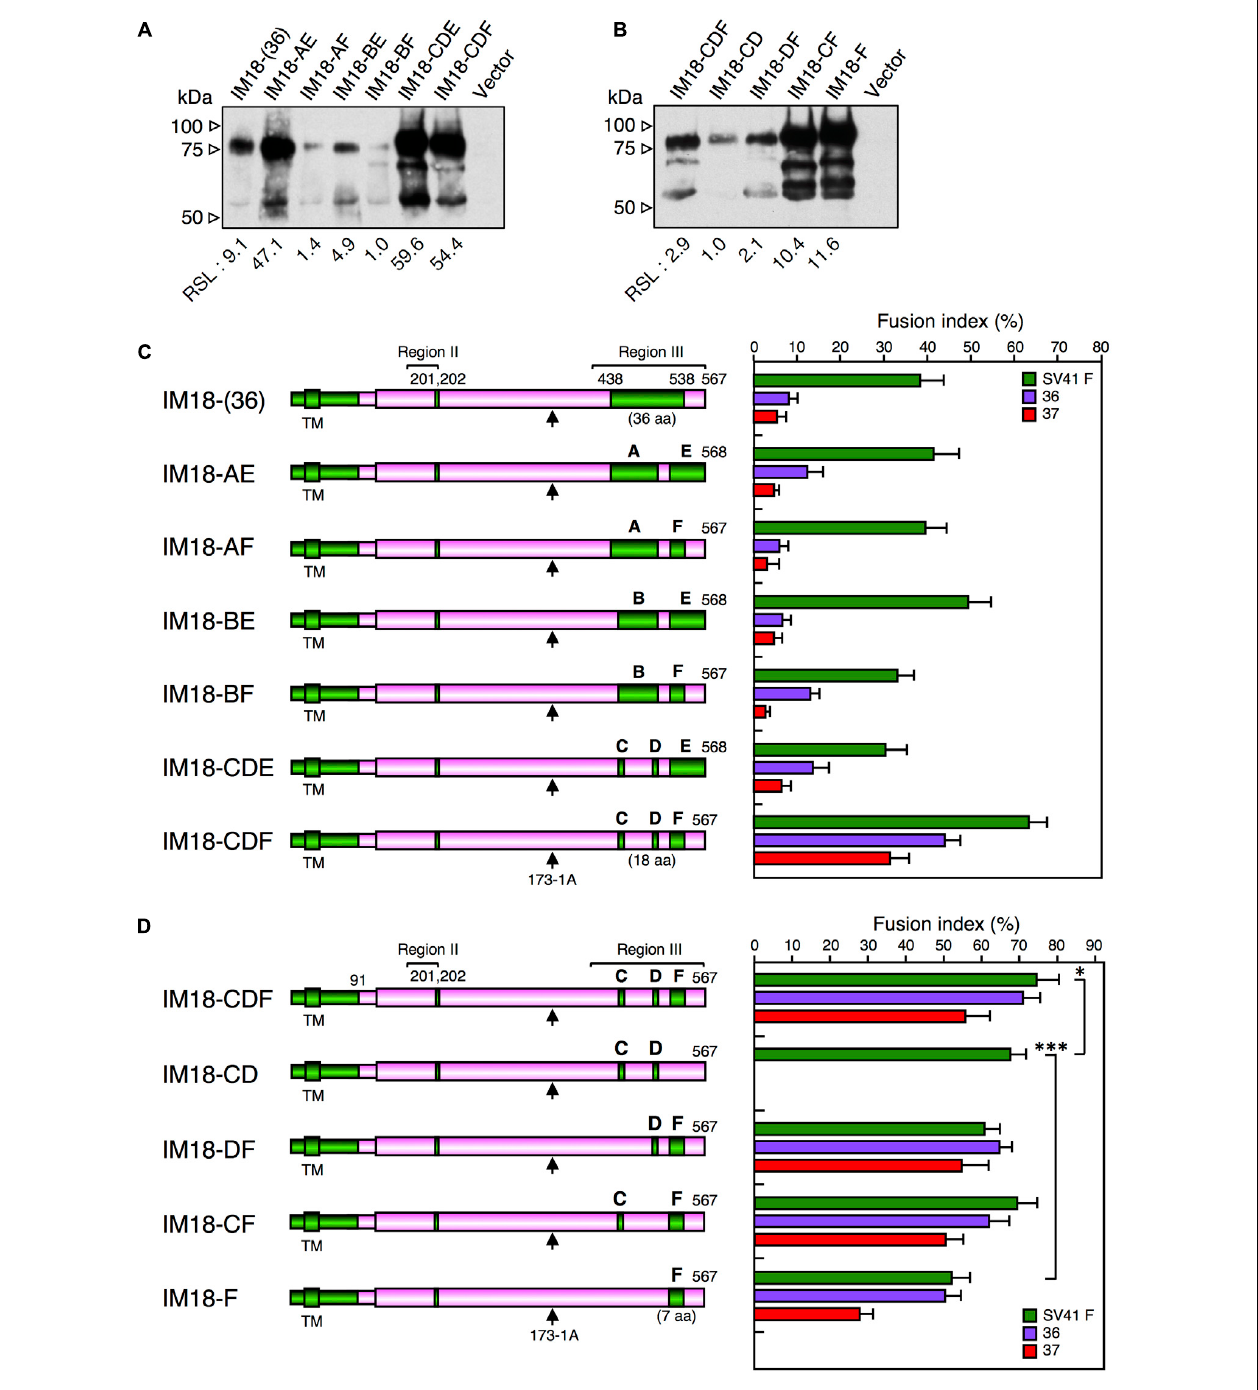
FIGURE 6 | SV41 HN-derived segment F is important for exhibiting the SV41 HN-like F protein specificity. (A,B) Detection of cell surface-localized HN proteins. The cell surface-localized HN proteins were detected as described in the legend for Figures 4A,B . Vector: pcDL-SR α expression vector used as the negative control. RSL, relative surface localization. (C,D) F protein specificity of the HN proteins. The average fusion index was determined at 24 h post transfection as described in the legend for Figure 2D ; error bars indicate standard deviation. The representative data of more than three independent experiments are shown. The fusion indices are not normalized to the cell surface-localization levels; the normalized data are shown in Supplementary Figures S8A,B . The statistical significance was evaluated by one-way ANOVA as described in the section “Materials and Methods” ( ∗ p < 0.05, ∗∗ p < 0.01, n = 10). Capitals above the cylinders indicate the SV41 HN-derived segments in the region III, which correspond to those shown in Figure 5C . Arrows indicate the positions of MAb 173-1A epitopes. The numbers of SV41 HN-derived amino acids in the region III were shown in the parentheses.